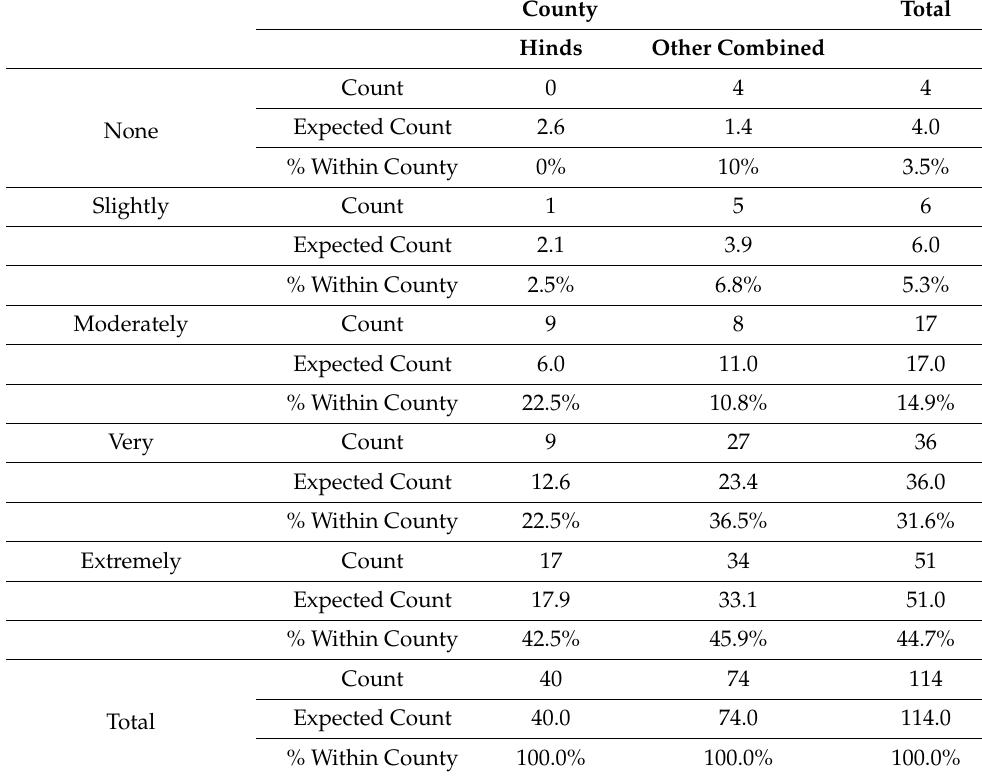
Table 4. Addressing health problems in the community by county of residence.